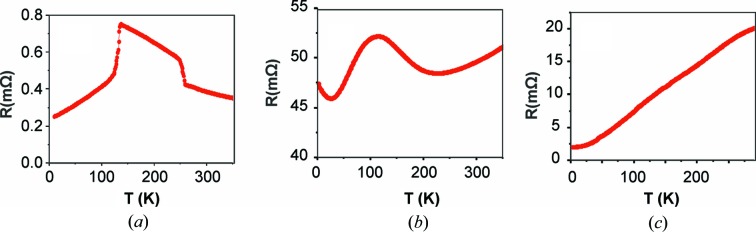
Resistance temperature dependence for crystals of P4W16O56 for categories SR (a), DS (b) and NO (c).